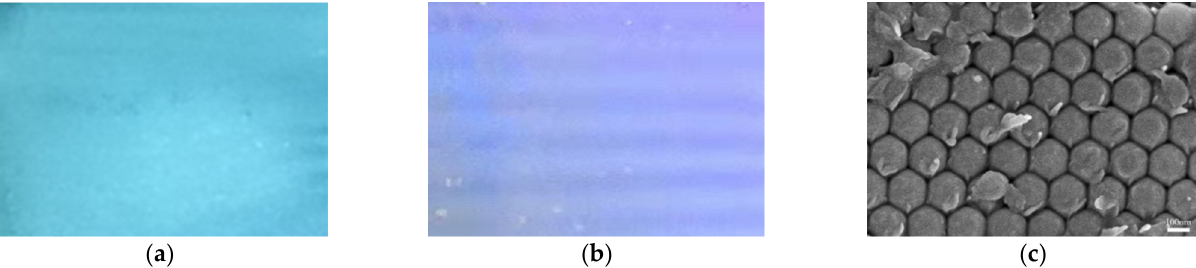
Figure 2. The photo under UV light ( a ) and visible light ( b ) and the SEM image ( c ) of the PEI-CdS QD-embedded photonic crystal hydrogel.